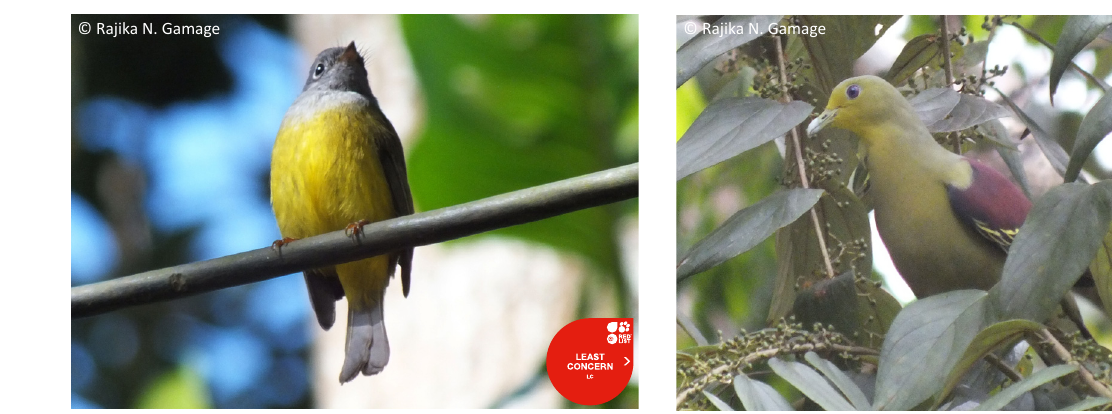
Image 8. Grey-headed Canary Flycatcher Culicicapa ceylonensis